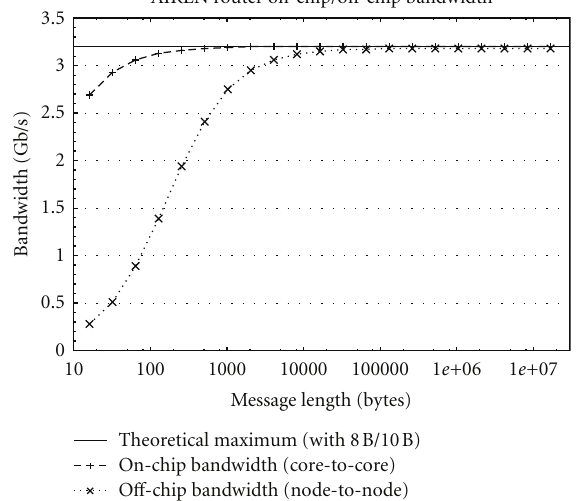
Table 2: Largest 32-bit full crossbar switch using 15% of device.